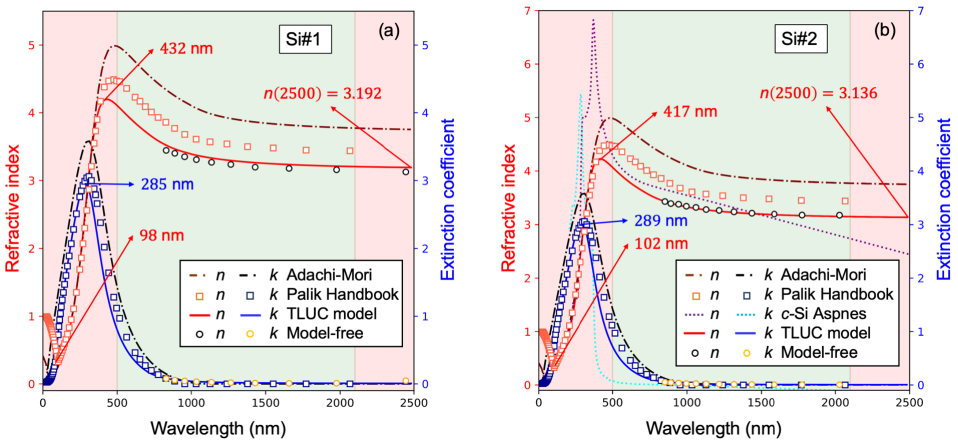
Figure 5. Complex refractive indices vs. vacuum wavelength, obtained from the two transmission spectra analyzed. Extrapolated refractive index, n , and extinction coefficient, k , of the two represen- tative RFMS- a -Si specimens, ( a ) Si#1 and ( b ) Si#2, following the adopted TLUC-oscillator function (plotted for the spectral range 0.5–100 eV, or, equivalently, 12–2482